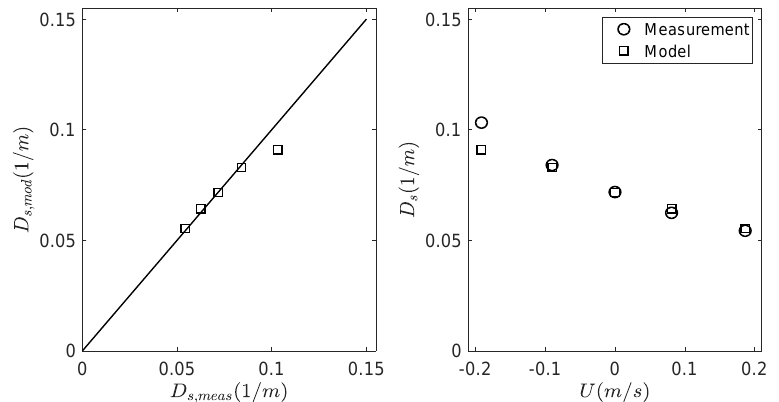
Figure 6. Comparison between the attenuation rates from the present model and laboratory experi- ments of An and Shibayama